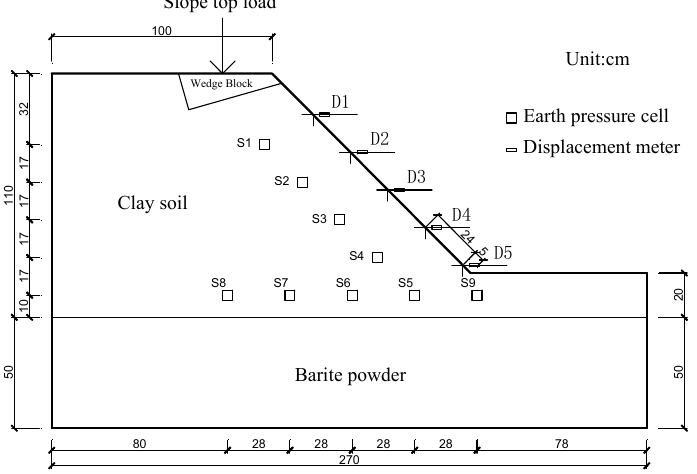
Figure 3. Test G1–G3 sensor arrangement.